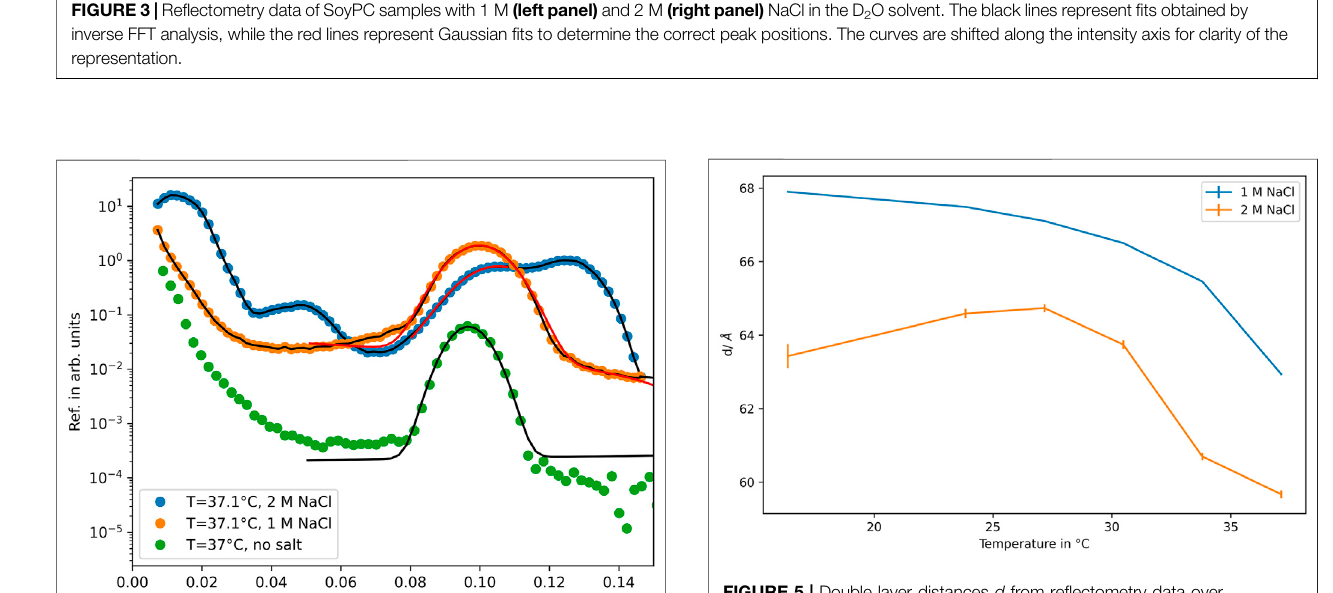
FIGURE 5 | Double layer distances d from re fl ectometry data over temperature. The error bars are vanishingly small for the 1 M NaCl